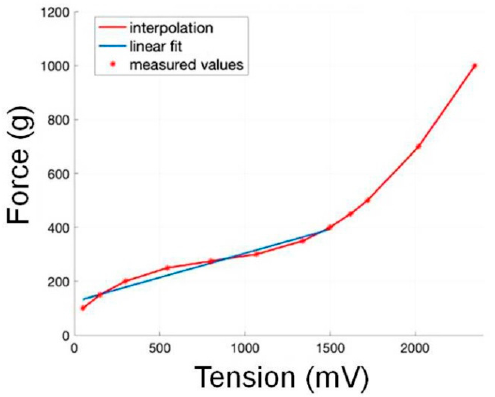
Figure 6. Relationship between force (in grams) and tension (in milliVolts) of the sensor output. The sensor output measured in the experiments varies essentially within the linear range (blue line).